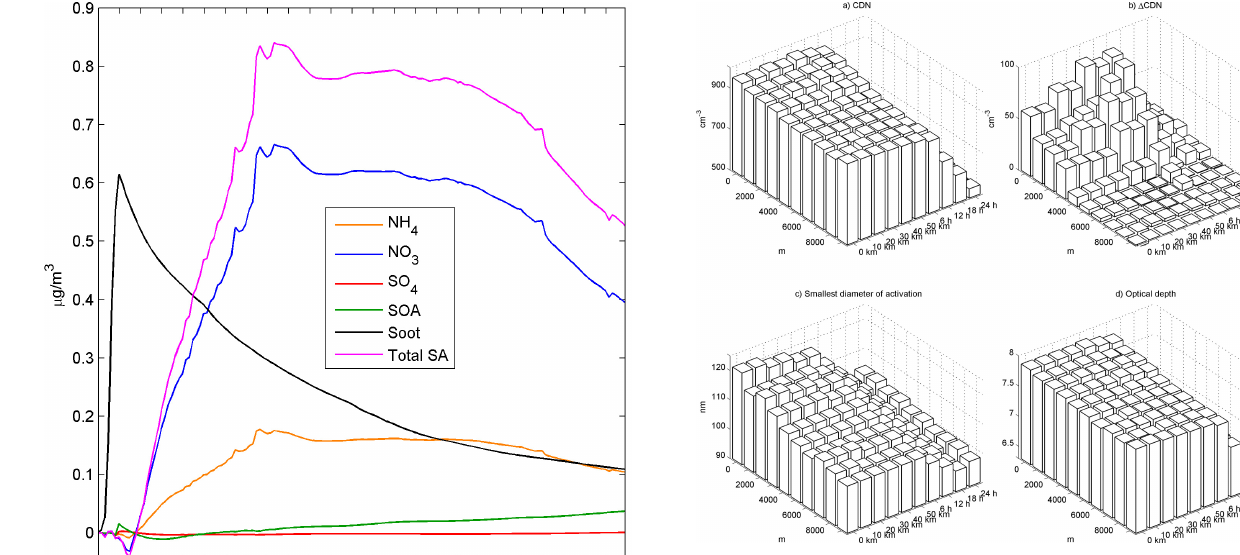
Fig. 10. Modeled cloud properties of a 100m thick cloud, at dif- ferent distances from the center of the urban plume (0–10km) and different distances (orh) downwind of Malm¨o for (a) total Cloud Droplets Number (CDN) concentration, (b) number of extra cloud droplets ( 1 CDN) due to the gas and particle emissions in Malm¨o, (c) the dry diameter of the smallest particles that are activated and (d) cloud optical depth of visible